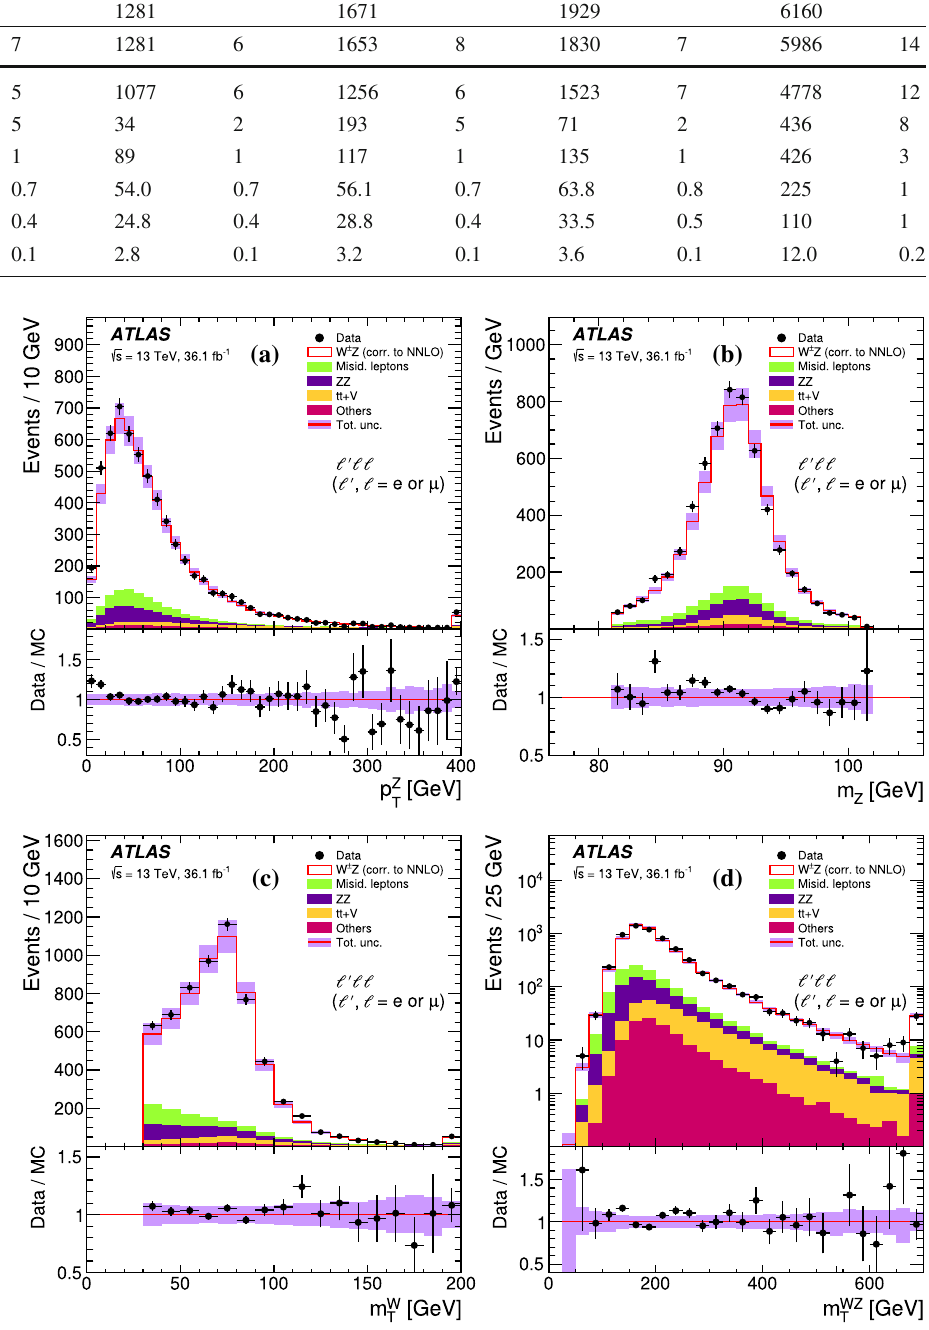
Table 1 Observed and expected numbers of events after the W ± Z inclusive selection described in Sect. 5 in each of the considered chan- nels and for the sum of all channels. The expected number of W ± Z eventsfrom Powheg+Pythia andtheestimatednumberofbackground events from other processes are detailed. The Powheg+Pythia MC